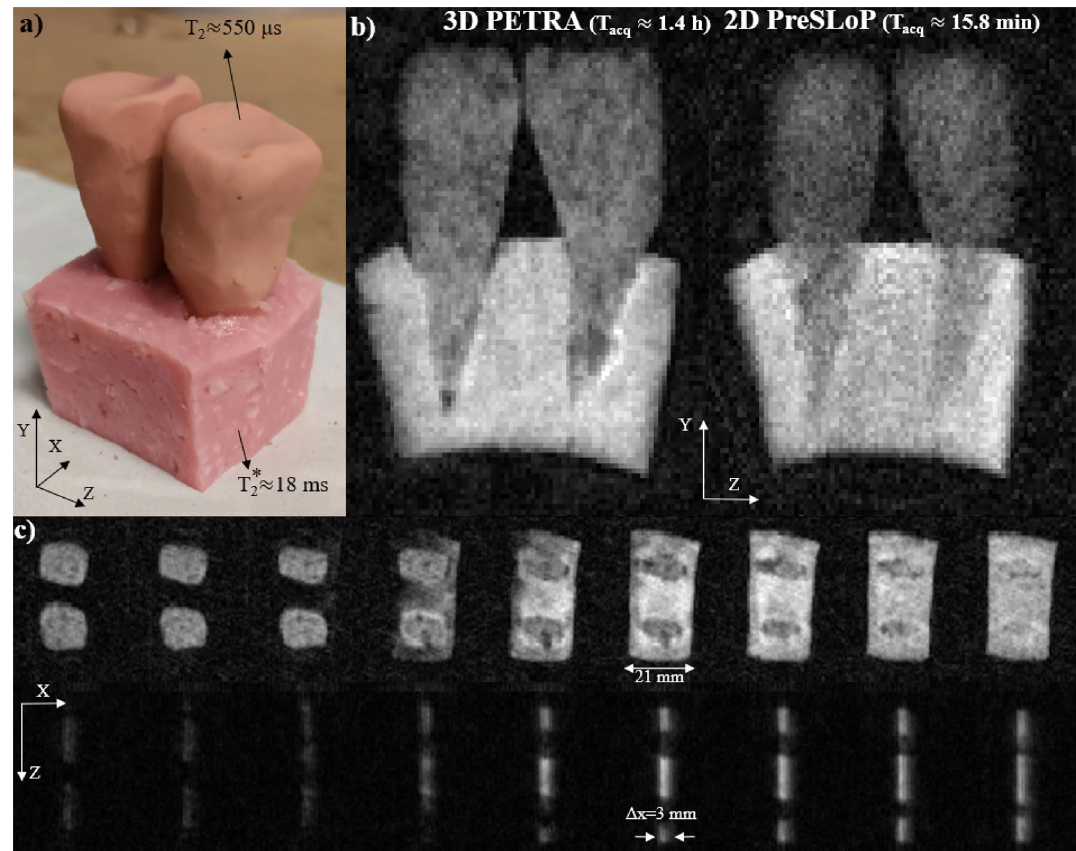
Figure 6. Performance of PreSLoP for a sample containing two clay tooth molds ( T 2 ≈ 550 µ s ) embedded in a piece of ham ( T ∗ 2 ≈ 18ms ). ( a ) Photograph of the sample. ( b ) 3D-PETRA (left) and 2D-PreSLoP (right). ( c ) 2D images for PETRA (top) with slice resolution ≈ 3 mm, and PreSLoP (bottom) with (cid:31) z ≈ 3